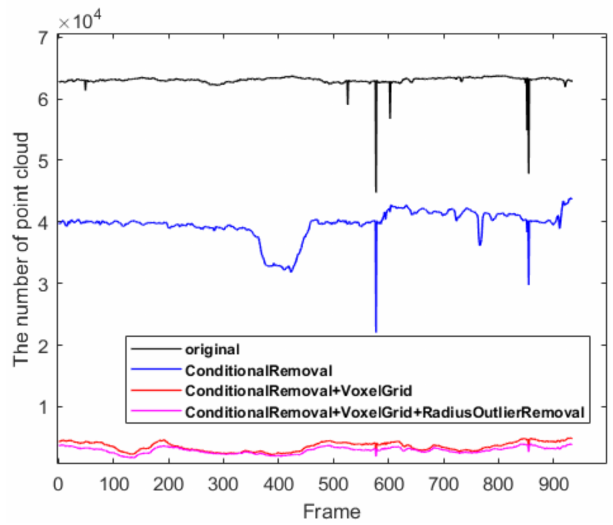
Figure 9. Rendering of lidar filtering.